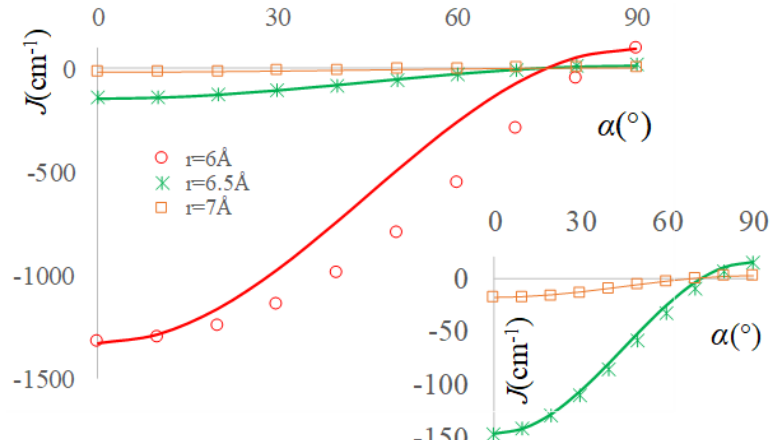
Figure 5. The exchange integrals as function of the α angle for ′ a ′ -type the TEMPO…CH 2 Cl 2 …TEMPO complexes. The marked points correspond to BS-DFT computed data, the continuous lines being emulated with the equation (8), according to the text discussion. The inset shows magnified representation of the curves at r = 6.5 Å and r = 7 Å separation of oxygen atoms from radicals. The red line is the fit for r =6 Å, the green line is for r =6.5 Å and the orange line is for r =7 Å.